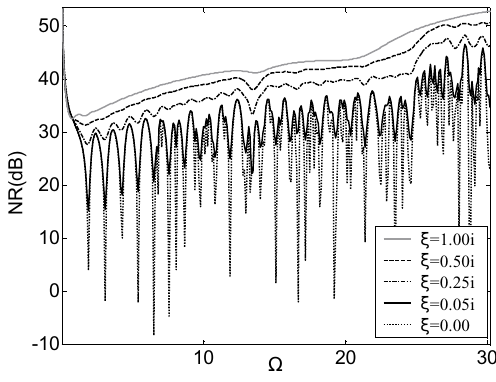
Fig. 15. Noise reduction for different absorption coefficient.